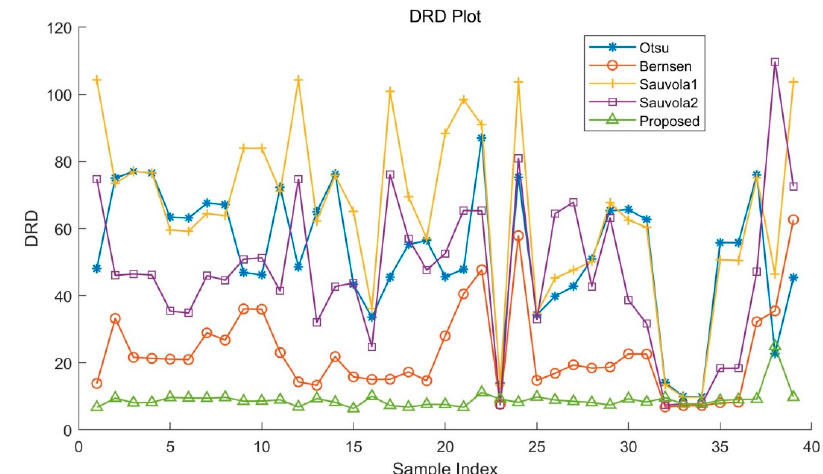
Figure 18. DRD of the dataset with different algorithms.